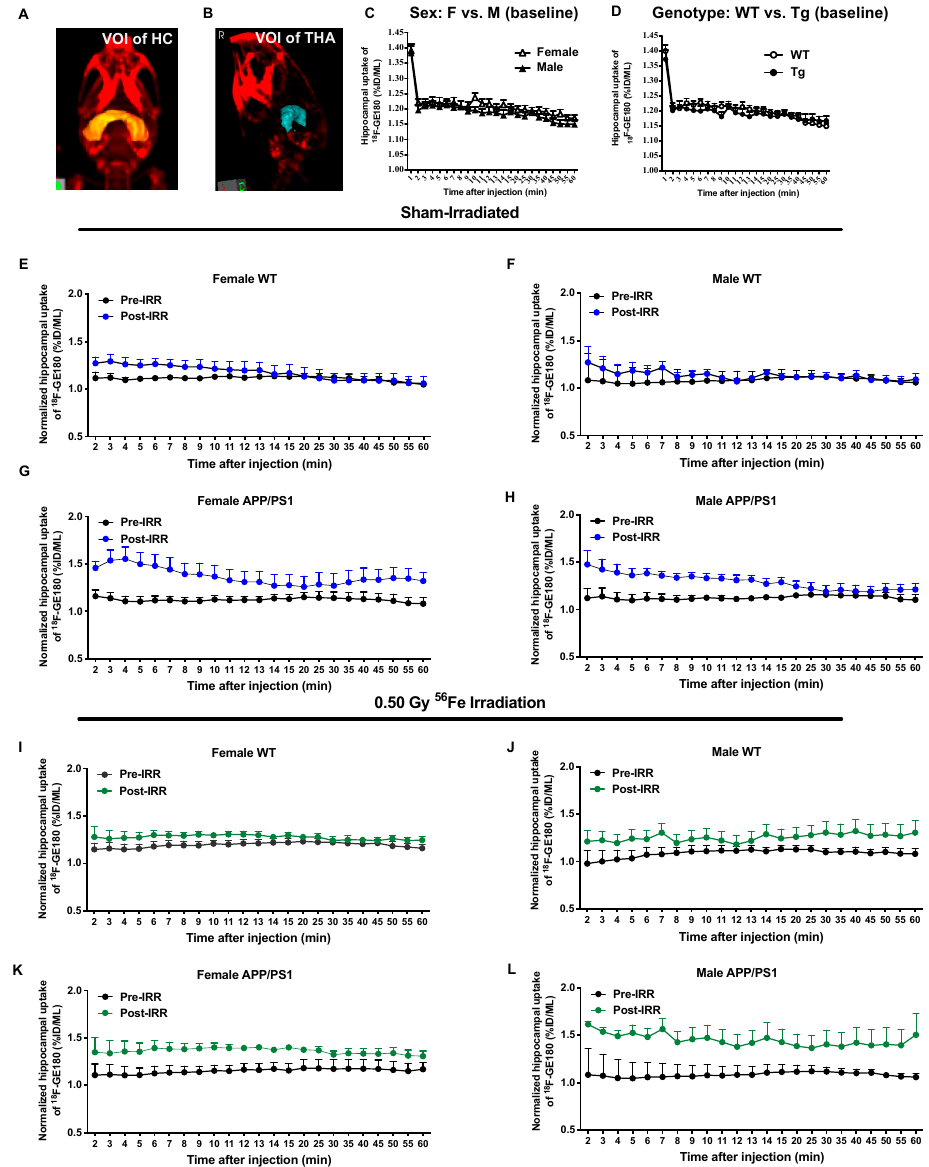
Figure 2. Hippocampal uptake of 18 F-GE180 PET tracer was increased in APP/PS1 mice without 56 Fe irradiation. ( A , B ) For PET imaging analysis, volume of interest (VOI) for hippocampus (HC, A ) and the reference region, thalamus (THA, B ), were as shown. ( C , D ) There was no significant sex ( C ) or genotype ( D ) difference in baseline uptake (pre-irradiation PET at 3.5 months of age) of 18 F-GE180. ( E – H ) APP/PS1 female ( G ) and male ( F ) mice showed pathology- and aging-associated increases in post-irradiation hippocampal uptake of 18 F-GE180 when compared with female and male WT mice ( E , F ). ( I – L ) The 0.50 Gy 56 Fe irradiation increased post-irradiation hippocampal uptake of 18 F-GE180 at 11 months of age in APP/PS1 female ( K ) and male ( L ) mice compared to female and male WT mice ( I , J ). n = 3–4 mice/group. A 2-way ANOVA followed by Bonferroni’s post hoc test was used for 18 F-GE180 uptake